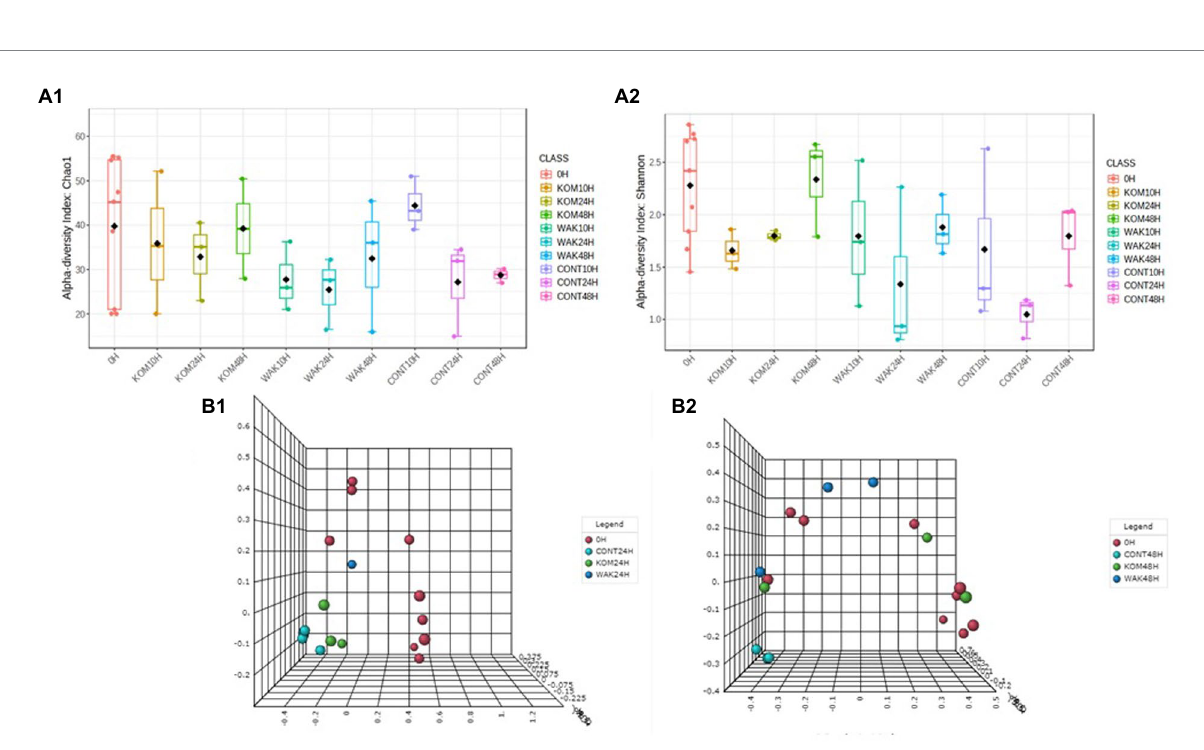
FIGURE 4 Evolution of the α -diversity, using two indices: Chao ( A .1) and Shannon ( A .2), of the operational taxonomic units in the samples and β -diversity, variation of microbial communities between different samples, using Bray–Curtis index at 24 h ( B .1) and 48 h of each seaweed ( B .2) compared to baseline (0 h). CONT (negative control, without substrate); KOM (kombu; S. japonica ); WAK (wakame; U. pinnatifida ).